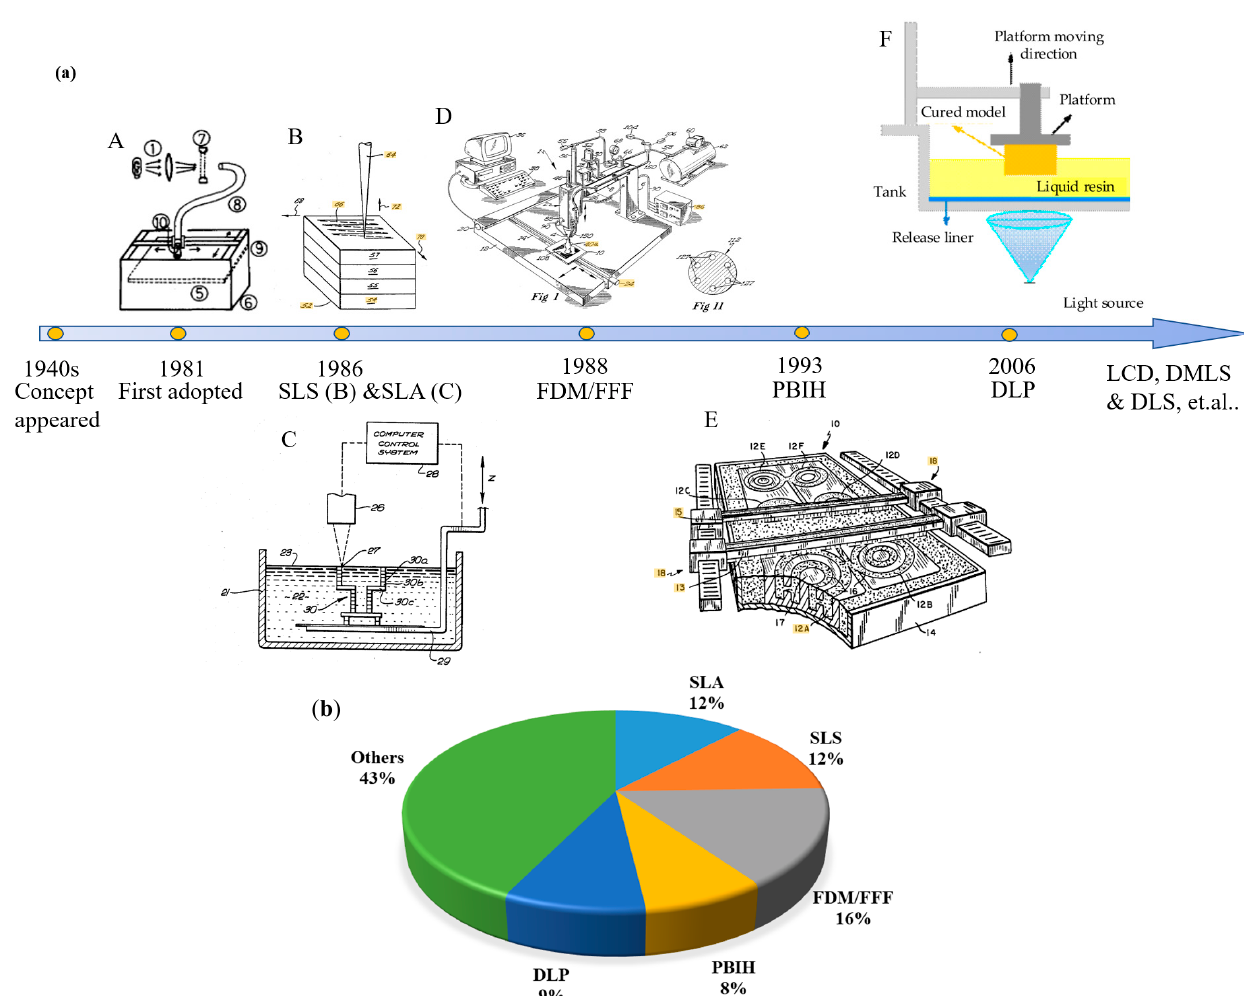
Figure 1. ( a ) Brief history of 3D printing development. A : The diagram of the first adopted 3D- printing technology [23], B : The diagram of SLA [25], C : The diagram of SLS [29], D : The diagram of FFF/FDM [32], E : The diagram of PBIH [33], F : The diagram of DLP [34]. All cited figures in this paper were reproduced with permission. ( b ) The most used 3D printing technologies worldwide in 2021, data were obtained from